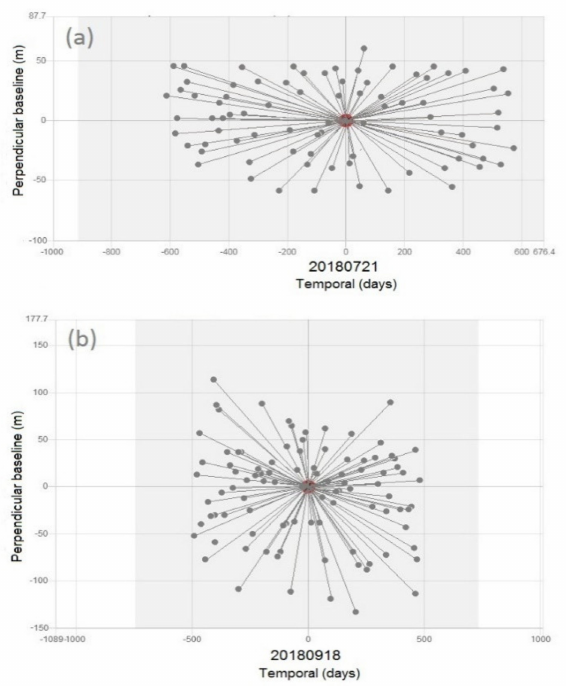
Figure 4. Connection graph between the master (red dot) and slave (black dots) images gener- ated with the PSI method. Graphs were obtained from ( a ) the descending and ( b ) the ascending Sentinel-1